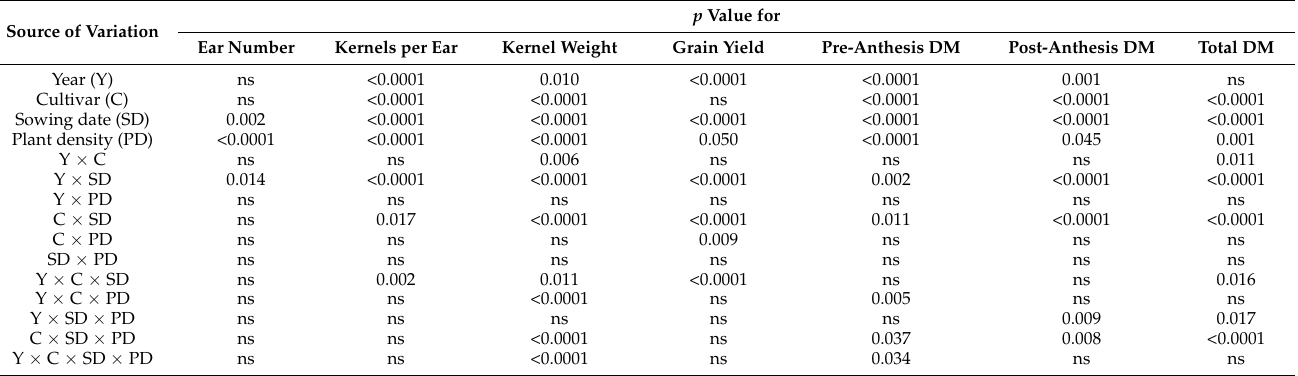
Table 2. Analysis of variance on grain yield, yield components, and dry matter